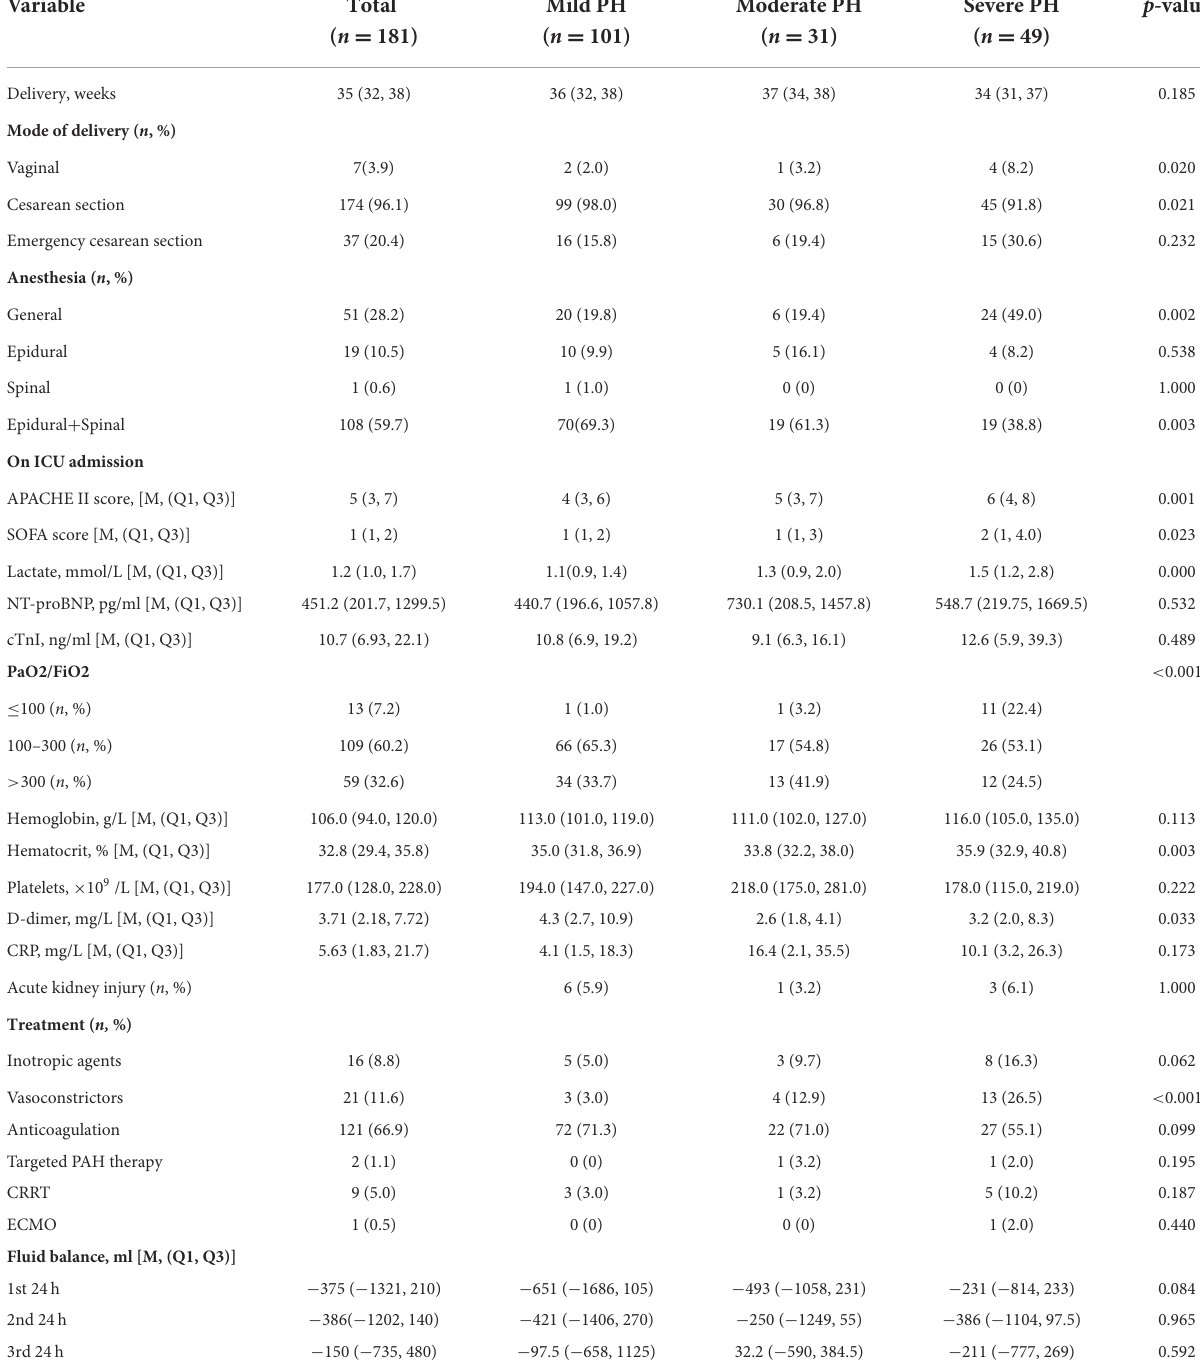
TABLE 2 Management of pregnant patients with pulmonary